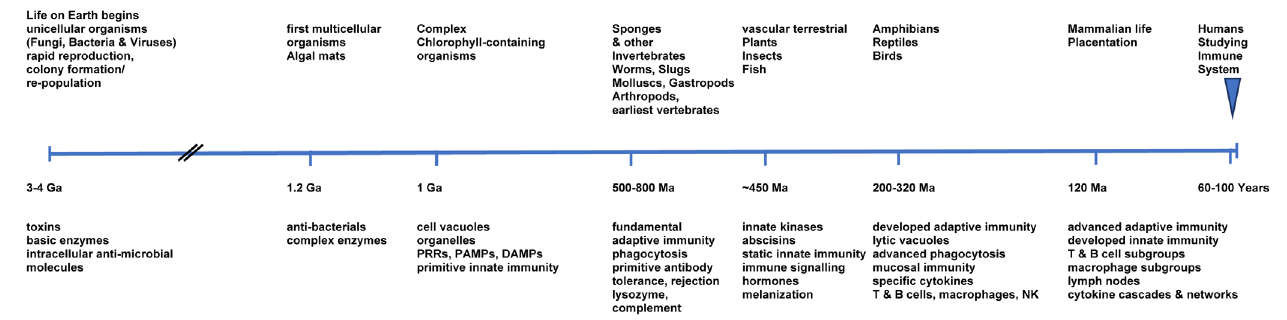
Figure 1. Timeline of estimated and known evolutionary developments of Life on Earth, and parallel changes in development of the immune system components [Ga = Giga/ billion / 10 9 years; Ma = Mega/ million /10 6 years; PRR = pattern-recognition receptors; PAMPs = pathogen associated molecular patterns; DAMPs = damage (or danger)-associated molecular patterns; NK = natural killer cells]. Note: representative non-linear timeline